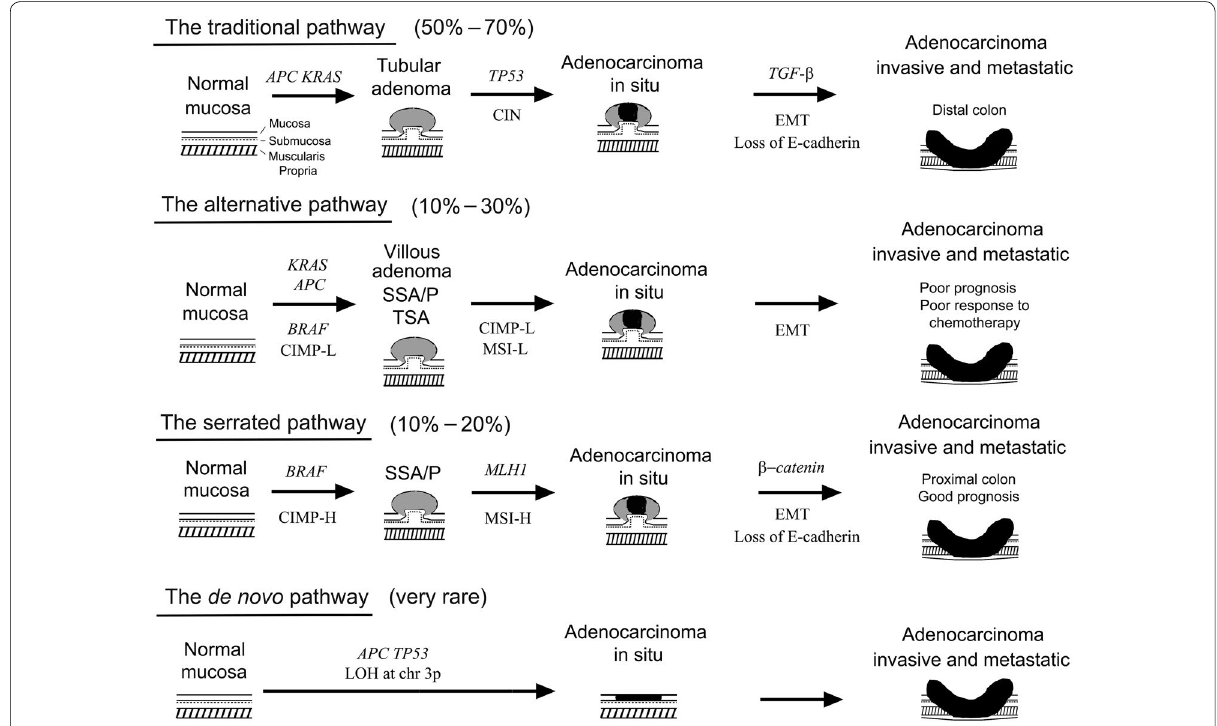
Fig. 1 Evolutional pathways for colorectal morphogenesis. The traditional pathway is the most homogenous pathway, originating from tubular adenoma (via adenomatous polyposis coli ( APC ) and subsequently Kirsten rat sarcoma viral oncogene homolog ( KRAS ) mutation) and leading to adenocarcinoma [via tumor protein 53 ( TP53 ) mutation]. This pathway is characterized by chromosomal instability (CIN), negative CpG island methylator phenotype (CIMP), and average outcome. The serrated pathway is also the most homogenous pathway, originating from sessile serrated adenoma/polyps (SSA/P) via B-Raf proto-oncogene, serine/threonine kinase ( BRAF ) mutation and CIMP-high (CIMP-H) and leading to adeno- carcinoma via MutL homolog 1 ( MLH1 ) promoter methylation and microsatellite instability-high (MSI-H). This pathway is characterized by good prognosis. The alternative pathway is more heterogeneous and may arise mostly from villous adenoma and perhaps also from SSA/P and traditional serrated adenoma (TSA) via CIMP-low (CIMP-L) and predominant KRAS but occasional BRAF mutations. This pathway lacks CIN and has the worse prognosis with low responsiveness to chemotherapy. The de novo cancers usually lack KRAS mutation but are significantly associated with TP53 and APC mutations and also loss of heterozygosity (LOH) at chromosome 3p (chr 3p). EMT epithelial-mesenchymal transition, TGF - β transforming growth factor-β, MSI-L MSI-low. A part of this figure was reproduced from figure 1 in Patholog Res Int 2012;2012:509348 authored by Pancione et al. [42], with